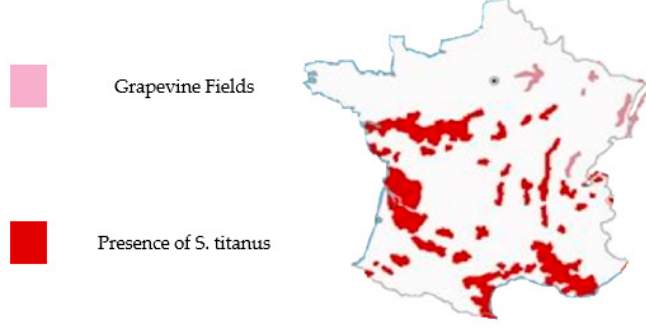
Figure 2. Vineyard distribution and S. titanus presence in France (from [24] modified).